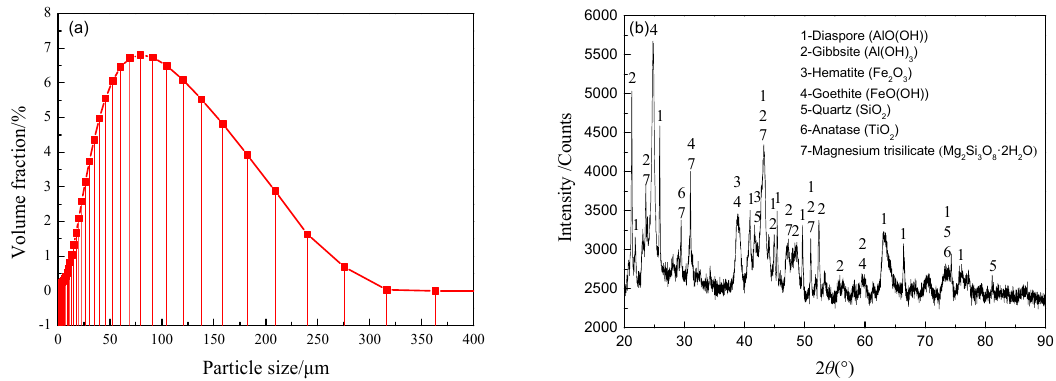
Figure 1. The particle size distribution ( a ) of mixtures, and XRD pattern ( b ) of an iron rich bauxite sample.